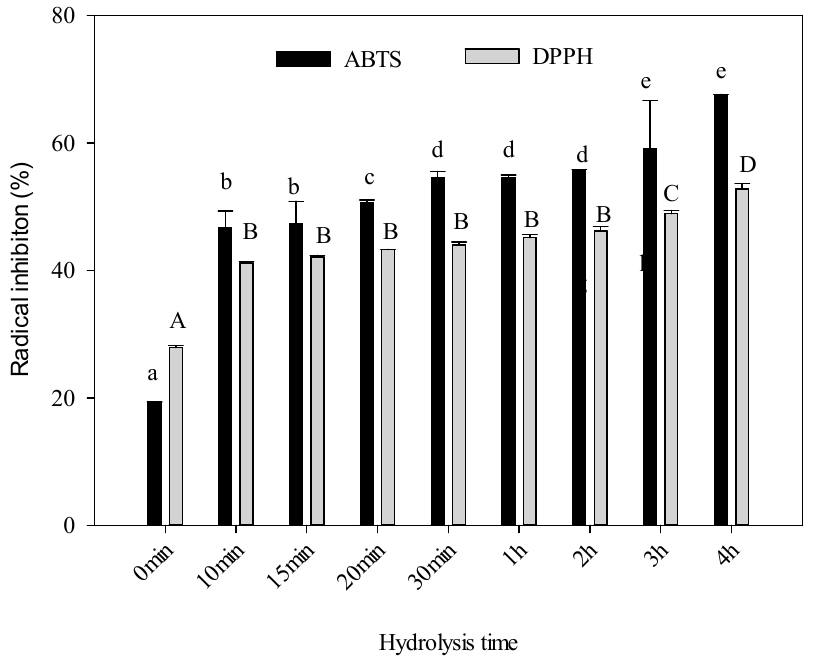
Figure 6. Antioxidant capacity of ovine collagen during hydrolysis. The activity was evaluated with TBS and DPPH methods. Values are expressed as the mean ± SD ( n = 3). Different letters indicate significant difference at p ≤ 0.05.